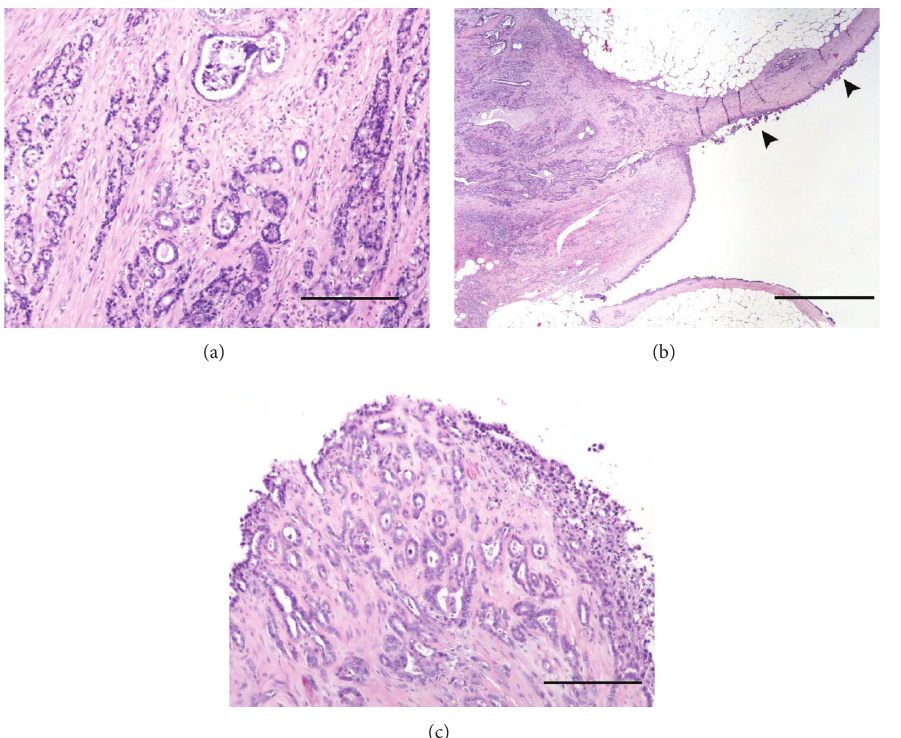
Figure 3: (a) Prostate gland: prostatic adenocarcinoma. Note the neoplastic cells arranged in nests and variably sized acinar structures amidst a dense fibrovascular stroma. Hematoxylin and eosin stain. Bar = 200 𝜇 m. (b) Omentum: note the metastatic spread of prostatic adenocarcinoma cells on the serosal surfaces forming small papillary fronds (arrowheads) and within the omental adipose tissue (carcinomatosis). Hematoxylin and eosin stain. Bar = 1000 𝜇 m. (c) Omentum: note the metastasis of prostatic adenocarcinoma cells on the serosal surface. Hematoxylin and eosin stain. Bar = 200 𝜇